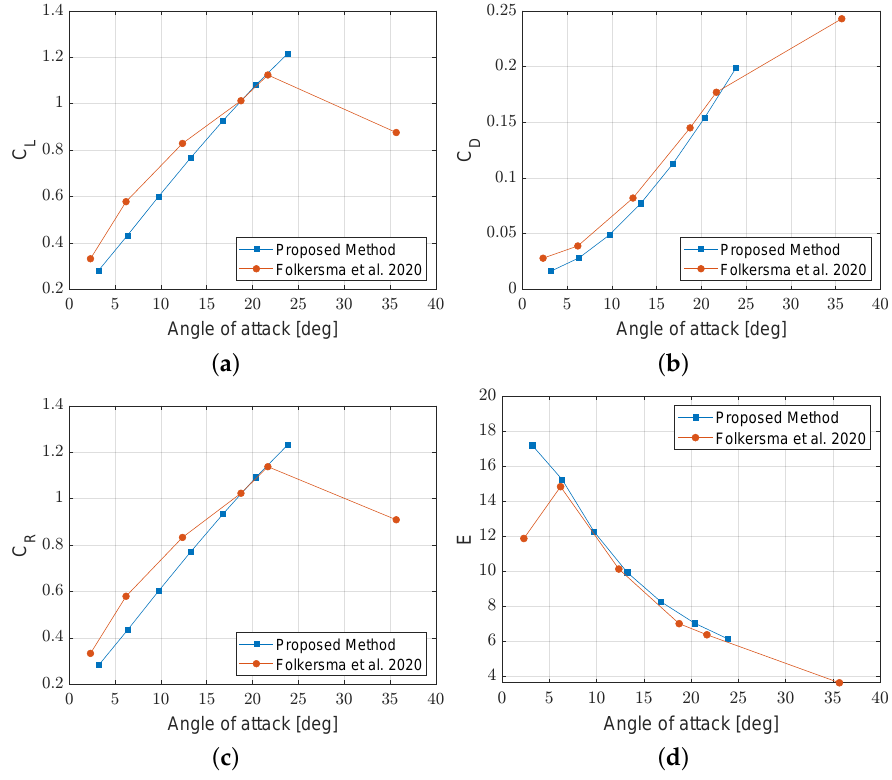
Figure 7. Computed aerodynamic properties as functions of the angle of attack at the center rib [20]. RANS data is taken from Folkersma et al. [18]. ( a ) Lift coefficient. ( b ) Drag coefficient. ( c ) Resultant force coefficient. ( d ) Glide